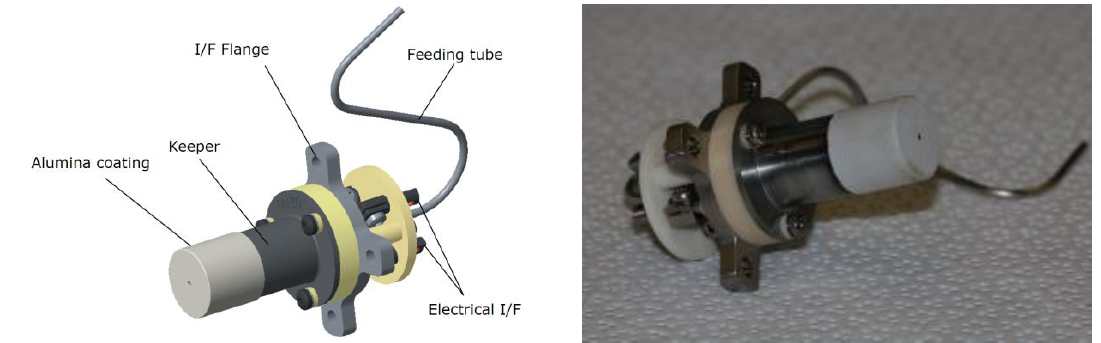
Figure 3. HC1 CAD (Computer-Aided Design) view with the structural elements indicated (left). HC1 assembled before the test (right).